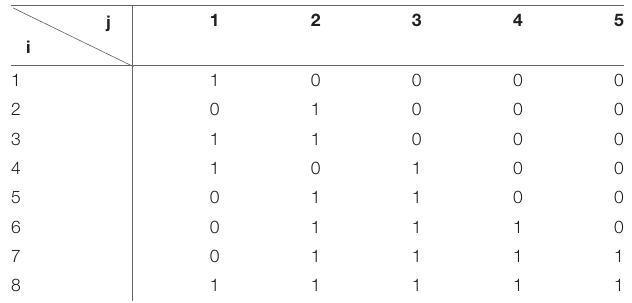
TABLE 1 | Deprivation matrix.